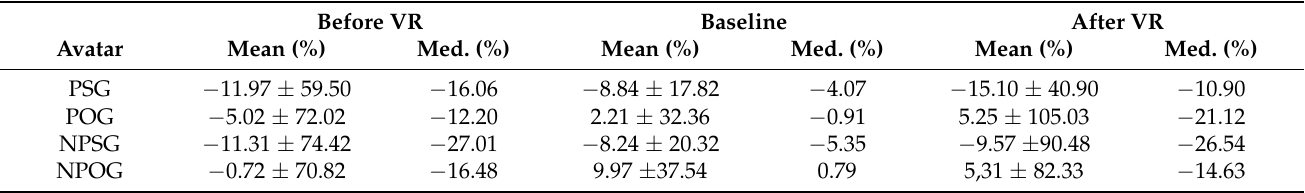
Table 5. Difference of the mean electrodermal activity of each avatar and the different segments of the study. The average electrodermal activity of the segment was used as the base value. Before VR Baseline